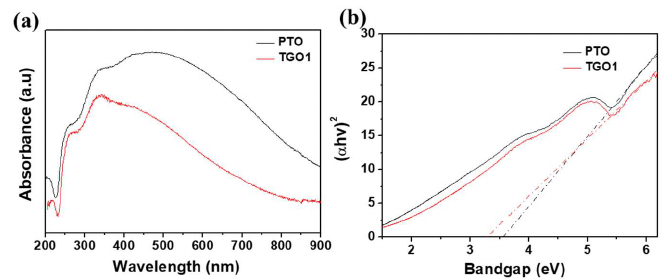
Figure 5. ( a ) Diffuse reflectance spectra and ( b ) Kubelka–Munk plots for the calculated bandgaps of pristine SnO 2 aerogel (PTO) and SnO 2 aerogel/reduced graphene oxide (rGO) nanocomposites with an rGO loading of 0.1 wt.% (TGO1).